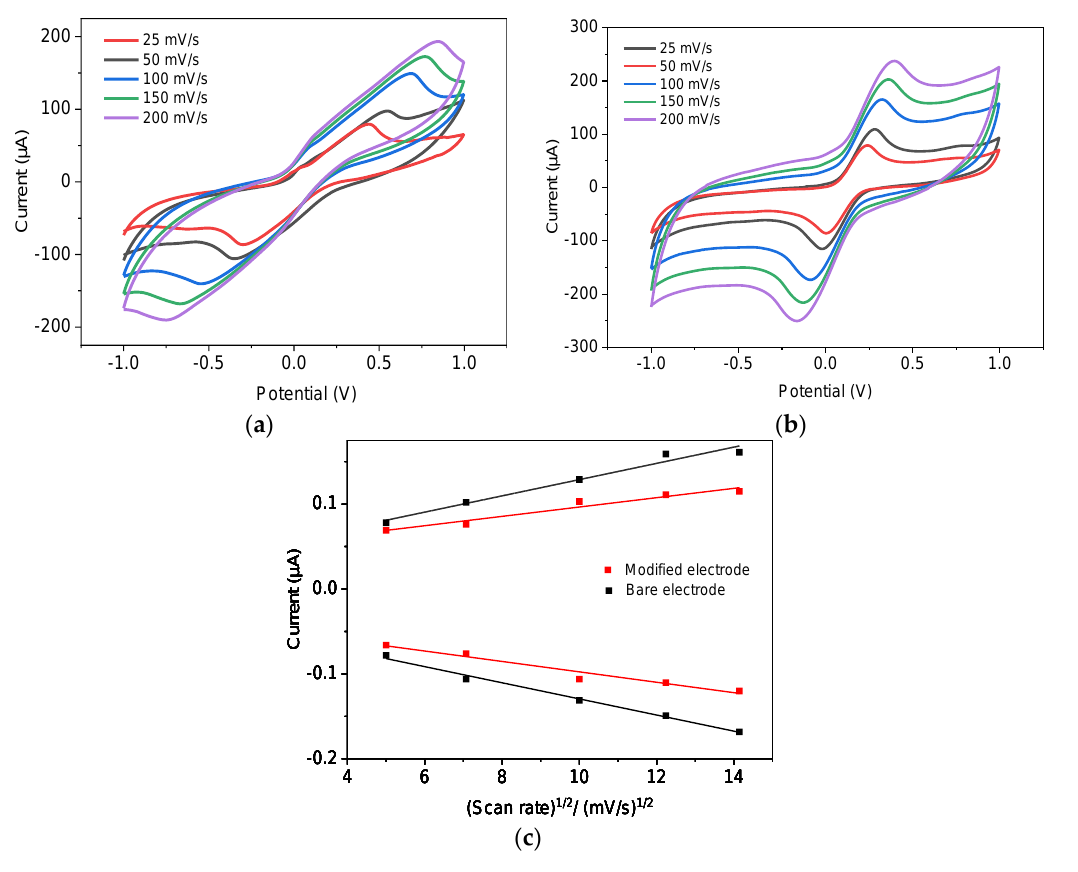
Figure 8. CV curves of ( a ) bare RGO electrode with RGO-IONs/PDAC in 0.1 M KCl solution containing 1.0 mM [Fe (CN) 6 ] 3 − /4 − at different scan rates; ( b ) modified RGO electrode with RGO- IONs/PDAC in 0.1 M KCl solution containing 1.0 mM [Fe (CN) 6 ] 3-/4- at different scan rates; ( c ) square root of scan rate as a function of the current of the bare electrode and the modified electrode.